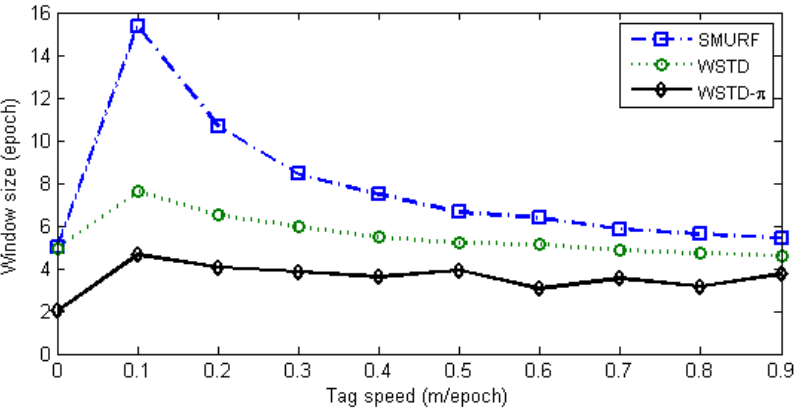
Figure 18. Comparison of variable window schemes’ cleaning windows as the tags velocity is varied.